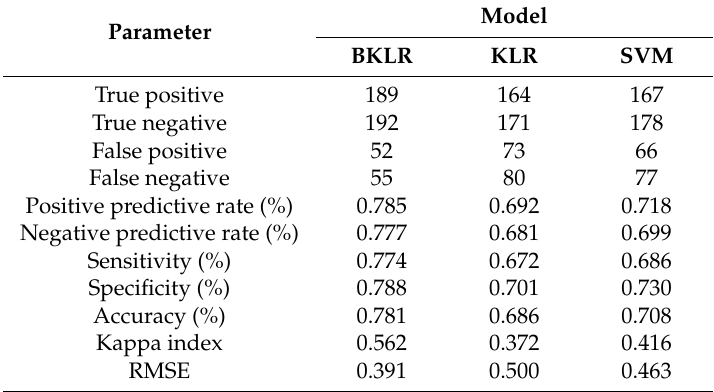
Table 2. Model performance comparison.